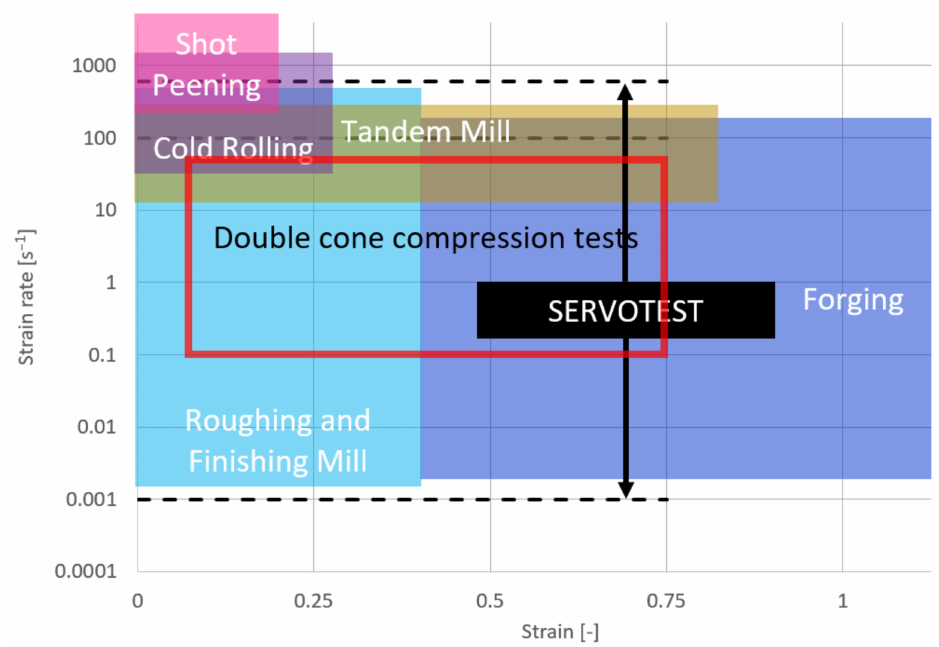
Figure 2. Typical process parameters in metal forming.